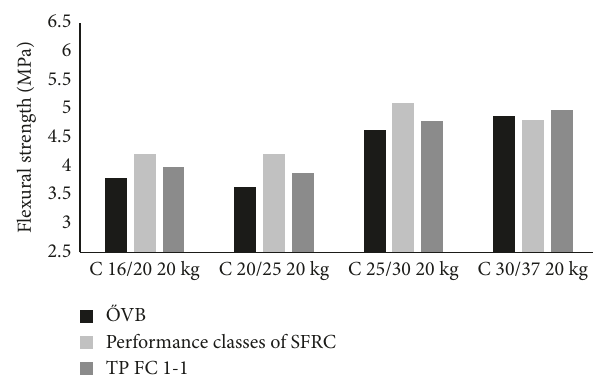
Figure 3: Bending strength of SFRC—amount of fibers: 20kg/m 3 .